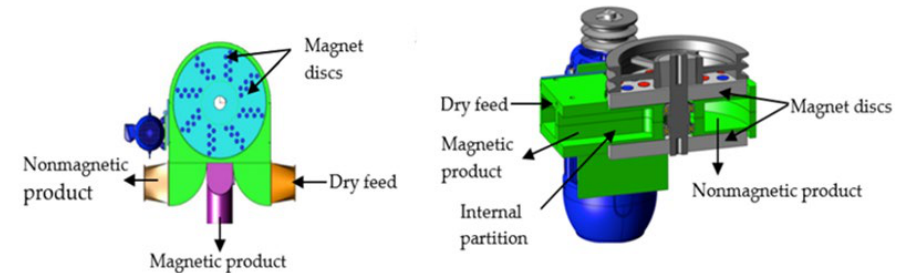
Figure 13. Novel pneumatic planar magnetic separator [51].